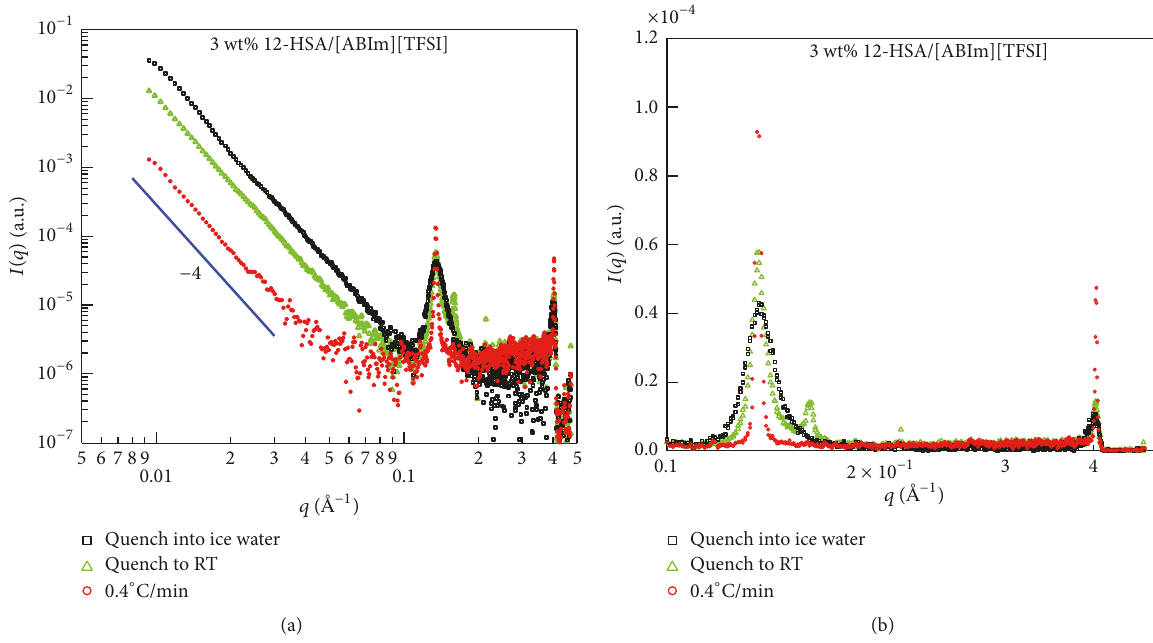
Figure 2: SAXS profiles for 3 wt% 12-HSA/[ABIm][TFSI] gel prepared by various cooling processes (a) and the magnification